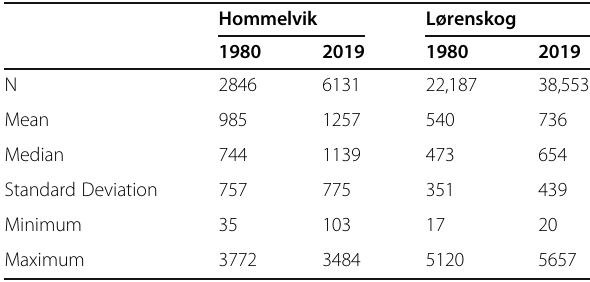
Table 1 Descriptive statistics of walking distance to nearest grocery store 1980 and